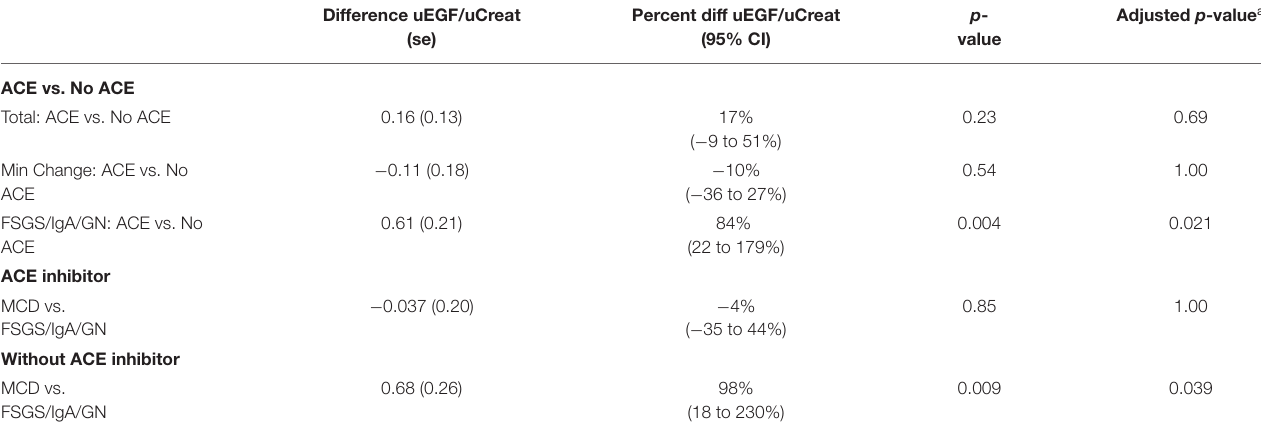
TABLE 7 | Comparisons based on linear mixed effects models with outcome log(uEGF/uCreat), random intercept, fixed effect for age, and combination of biopsy result and ACE inhibition. Difference uEGF/uCreat